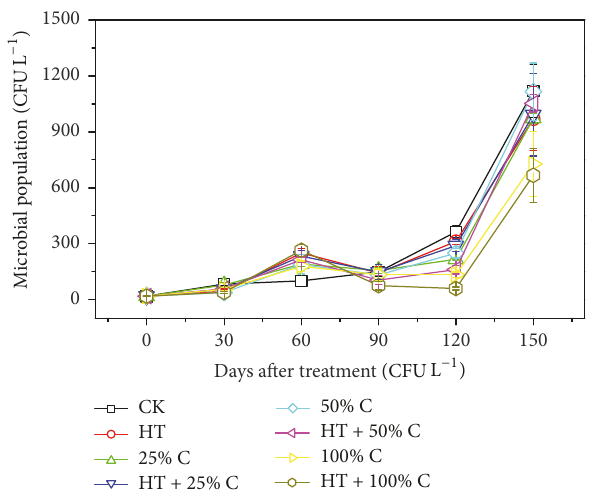
Figure 2: Effects of combined heat and preservative treatments on the epiphytic microbial population of Ponkan fruit during storage. “C” represents the concentration of preservative used in production. The error bars represent the standard errors. Three repetitions were used in this analysis.